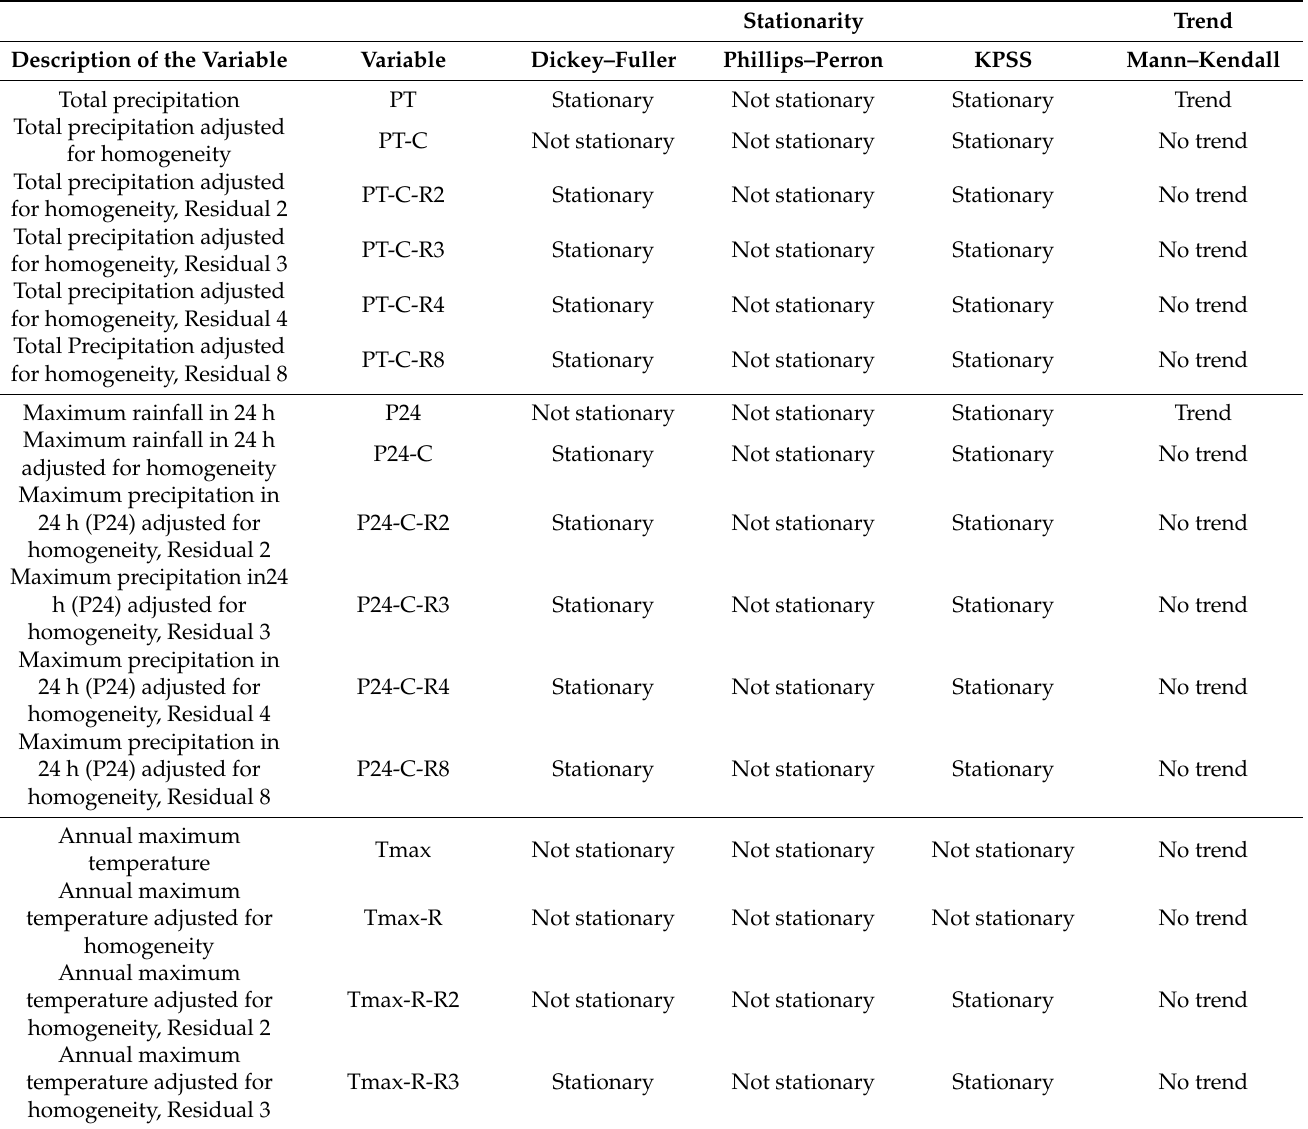
Table A2. Results of the stationarity and trend tests for total precipitation (PT-C) and the residual functions with two harmonics (PTC-R2), three harmonics (PTC-R3), four harmonics (PTC-R4) and eight harmonics